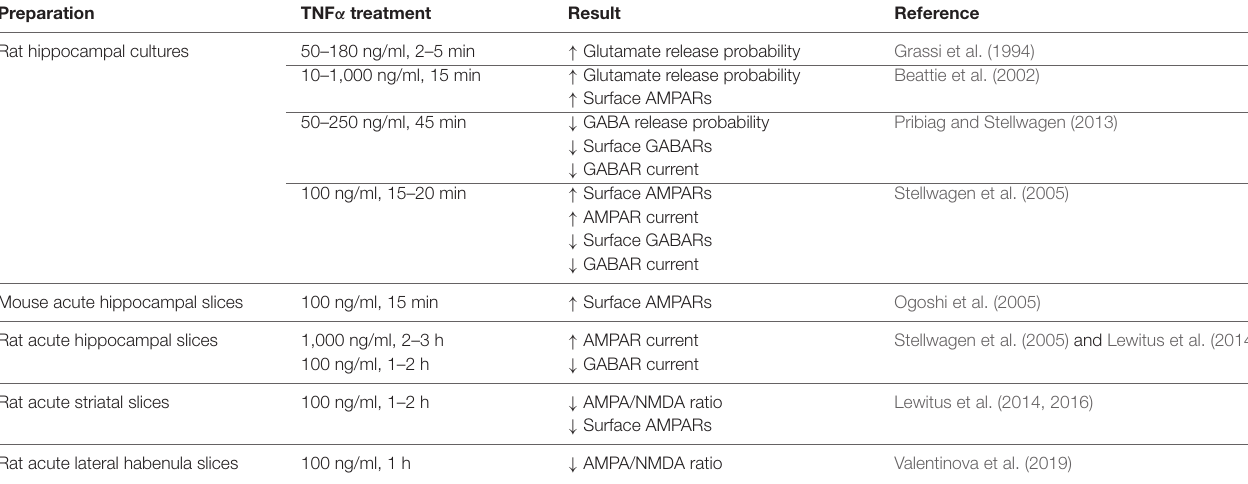
TABLE 1 | Details of the effects of tumor necrosis factor (TNF) on synaptic